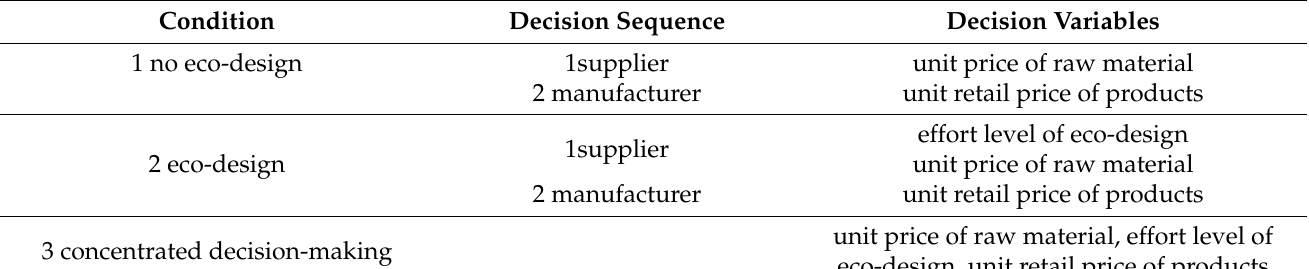
Table 1. Three eco-design situations and decision sequence and decision variables in the supplier chain.